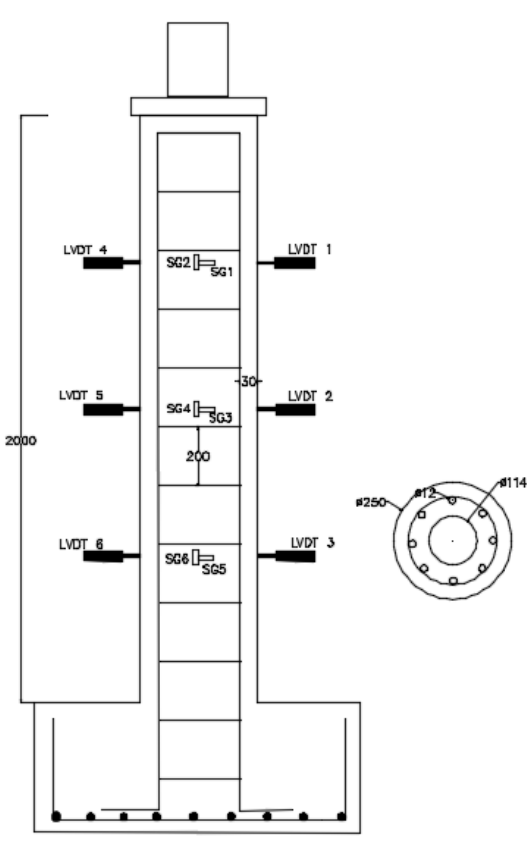
Figure 1. Detail of Specimen (dimensions in